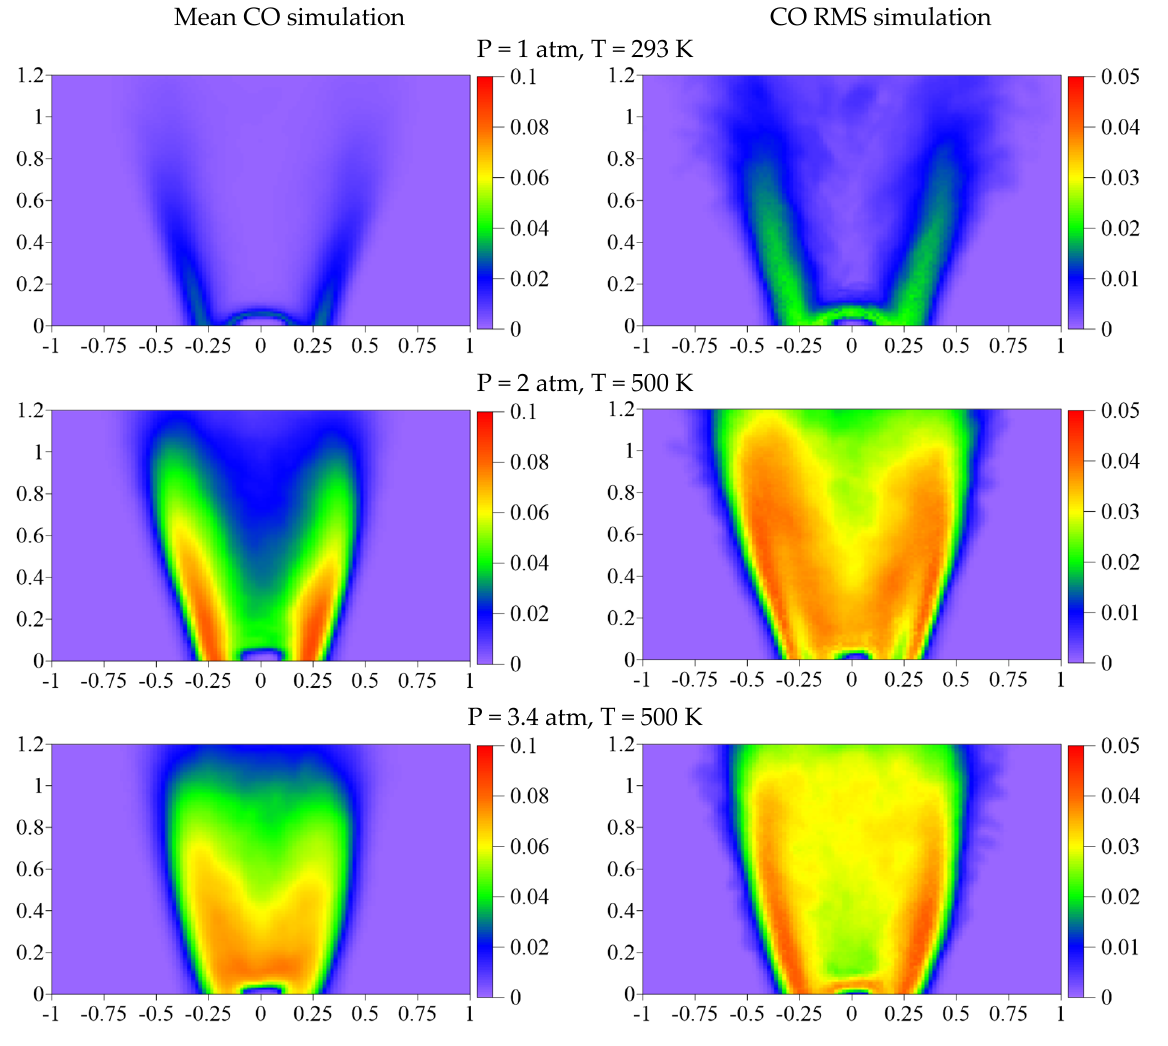
Figure 7. Mean CO concentration fields and RMS of the concentration fluctuations evaluated by the LES approach.